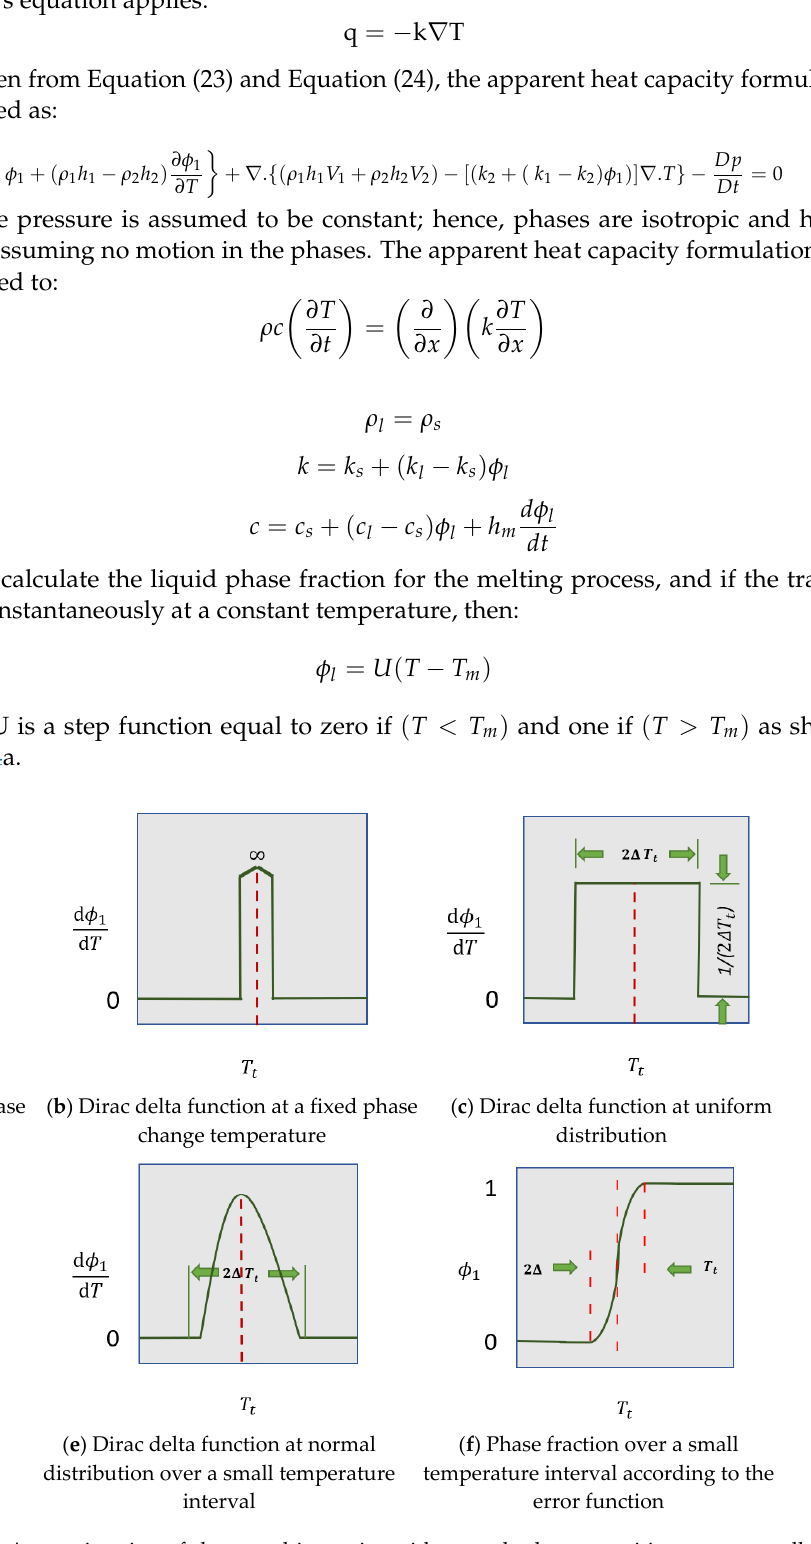
Figure 4. Approximation of sharp melting point with smooth phase transition over a small temperature interval with Dirac Delta and Error Functions.